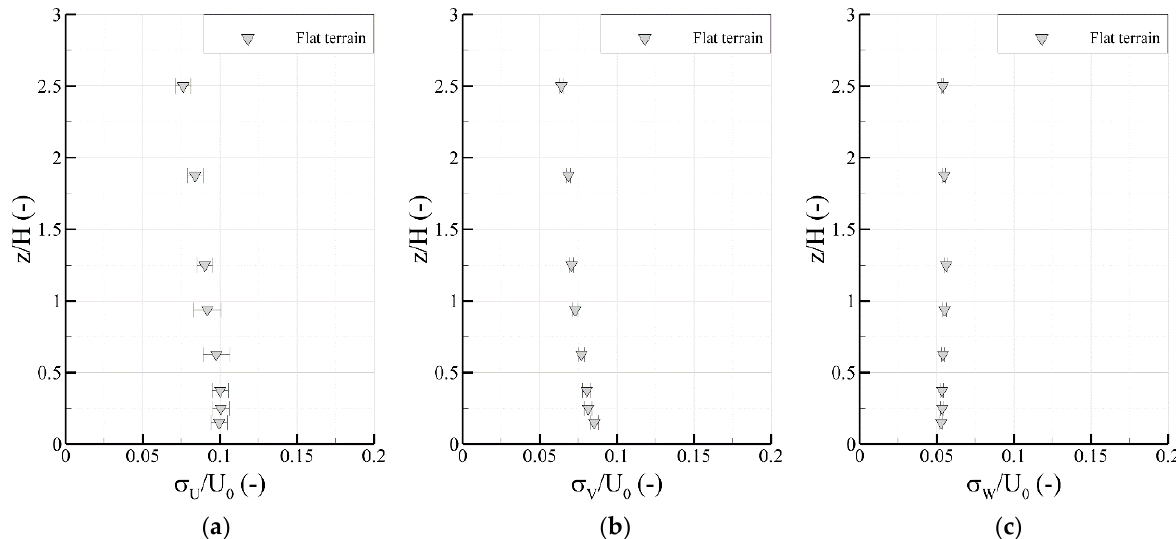
Figure 3. Vertical profiles of the longitudinal ( a ), lateral ( b ), and vertical ( c ) velocity fluctuations of the undisturbed flow above flat terrain.